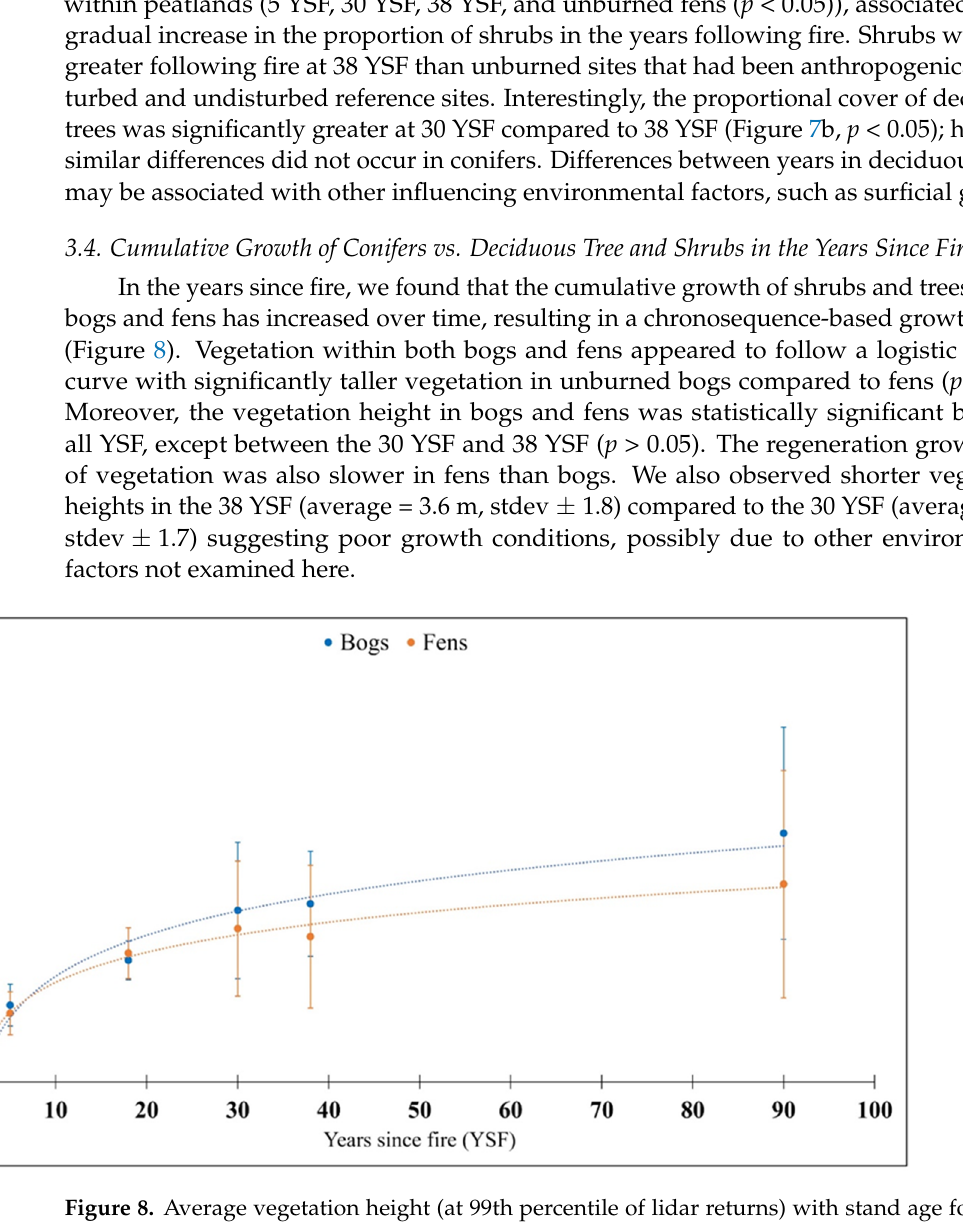
Figure 8. Average vegetation height (at 99th percentile of lidar returns) with stand age for boreal peatland fire chronosequence (R 2 = 0.96 for bogs, R 2 = 0.98 for fens). Unburned peatlands are plotted with an arbitrary stand age of 90 ± 10 years, though there may be many more years since the last fire, but not determined in the field and not included in the recent history of scientific observation (since ~1930).